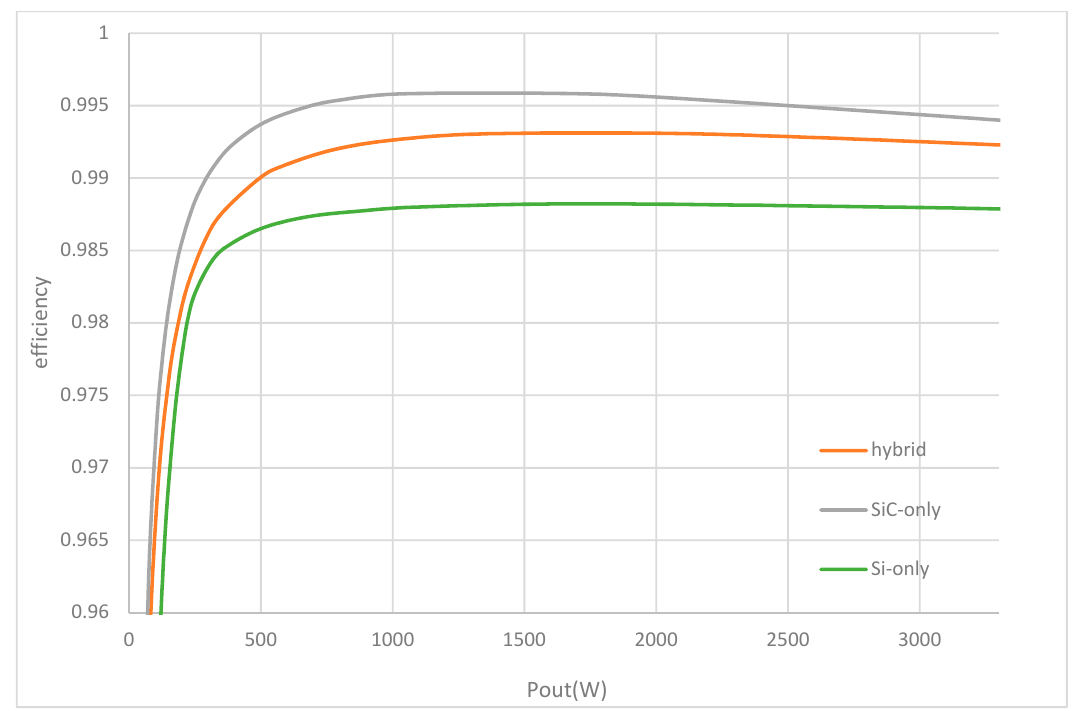
Figure 9. Comparison of the efficiency of the hybrid, Si-only, and SiC-only schemes.